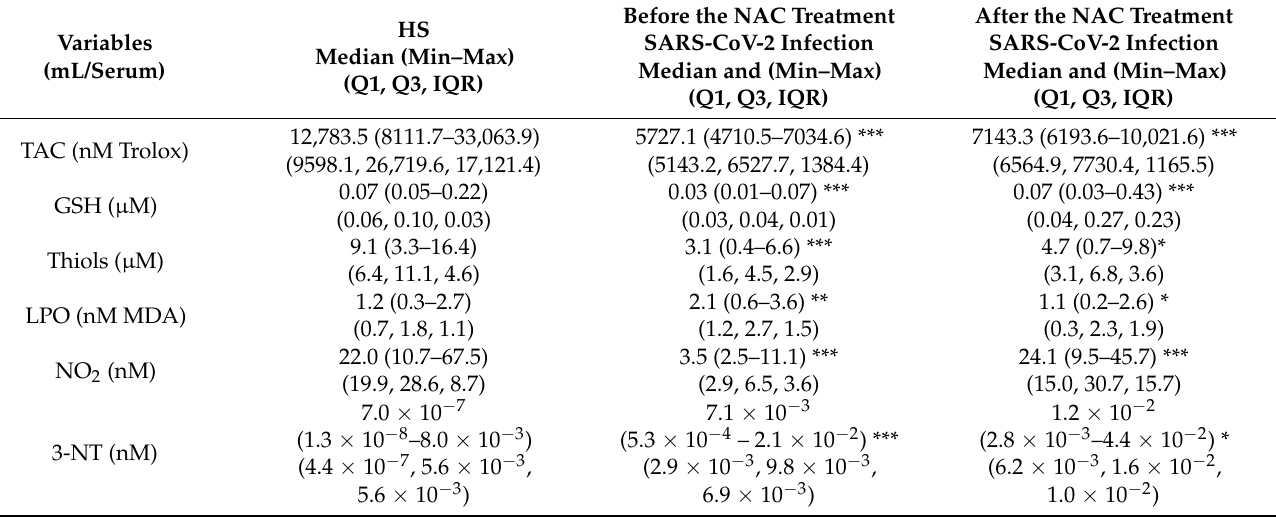
Table 3. Oxidative stress markers in healthy subjects and patients infected with